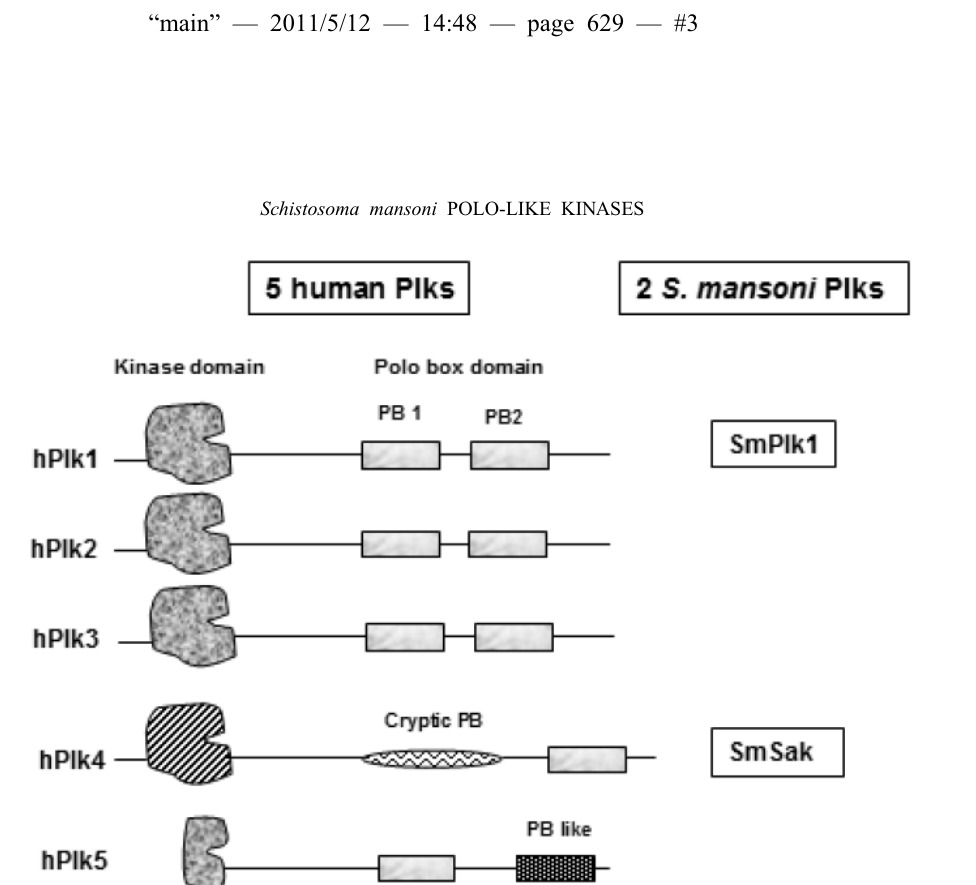
Fig. 1 – The polo-like kinase family . Schematic representation of the five identified polo-like kinases in human cells. hPlk1, hPlk2 and hPlk3 have similar structures, each composed of a Plk-conserved and specific Ser/Thr kinase domain in their N-terminal part and a polo-box domain formed by two conserved polo-boxes (PB1 and PB2) in their C-terminal part. hPlk4 is a divergent Plk (also named Sak) containing a less-conserved kinase domain and a polo-box domain composed of a cryptic polo-box and a single polo-box. hPlk5 has a structure similar to Plk1, 2 and 3 but the sequenceofhumanPlk5containsastopcodonthatproducesatruncatedproteinlackingtheN-terminalhalfpartofthekinasedomain(Archambault and Glover 2009, Andrysik et al. 2010). In the genome of S. mansoni (Berriman et al. 2009), only two genes encoding respectively SmPlk1 and SmSak have been found (Long et al.